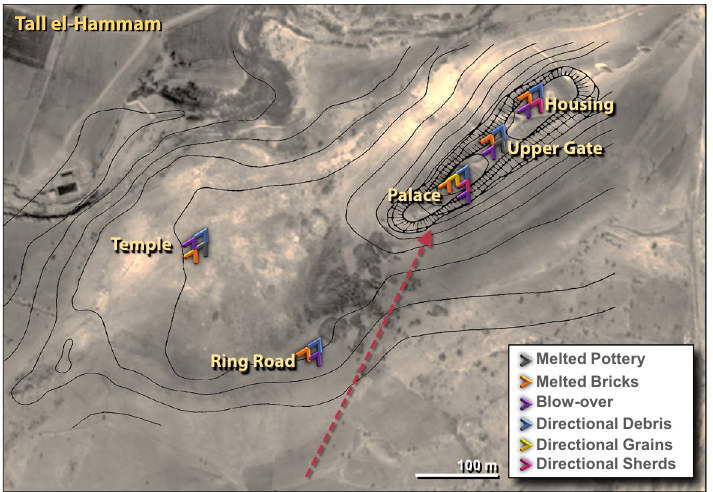
Figure 17. The directionality of debris across the entire TeH site. Color-coded arrows indicate the type and direction of six types of debris. Red dashed arrow and colored arrows mark the movement from SW to NE across excavations that span an area of ~ 58,000 m 2 (~ 480 m long by up to ~ 240 m wide). Created by the authors using Adobe Photoshop CC2014